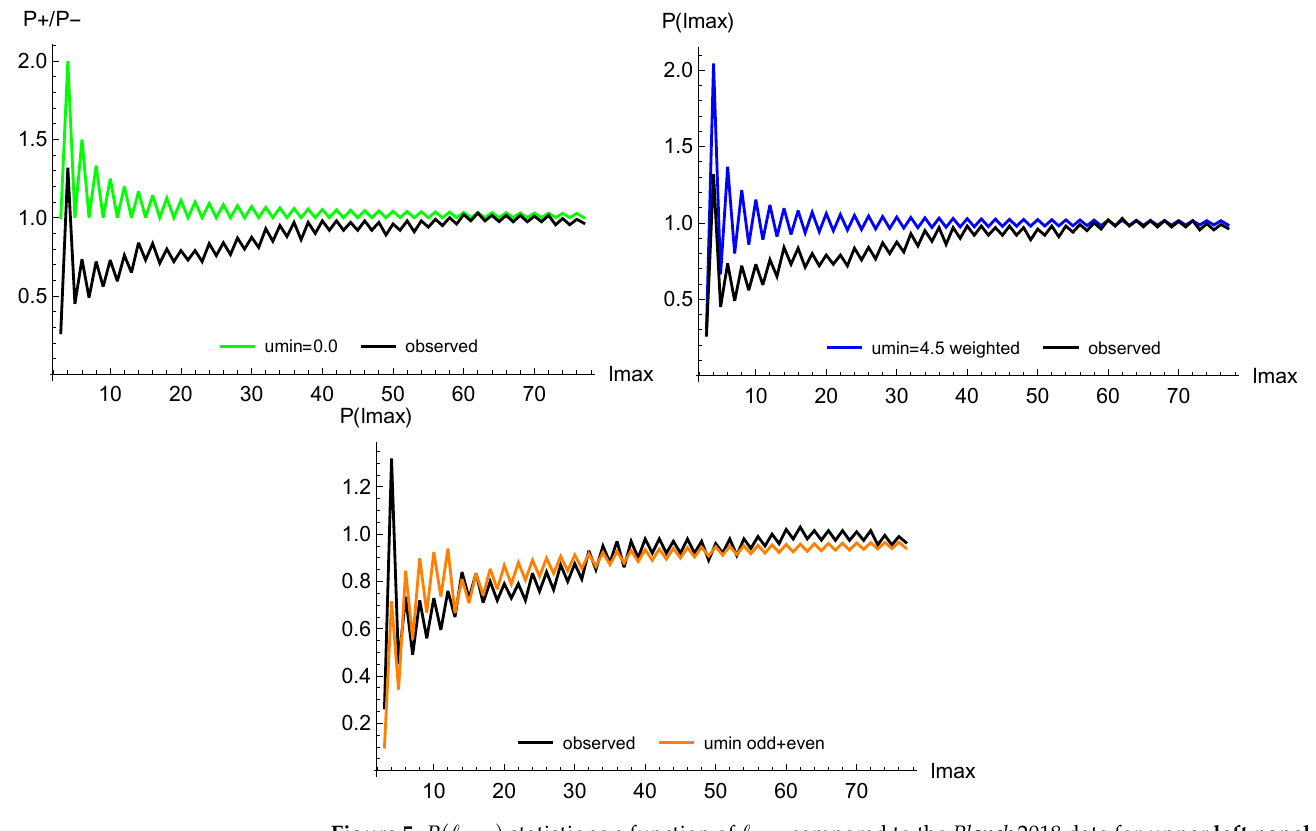
Figure 5. P ( (cid:96) max ) statistic as a function of (cid:96) max compared to the Planck 2018 data for upper left panel : u min = 0 and even-odd parity balance ( Λ CDM); upper right panel : u min = 4.5 and weighted C (cid:96) to get odd-parity dominance; lower panel : u even